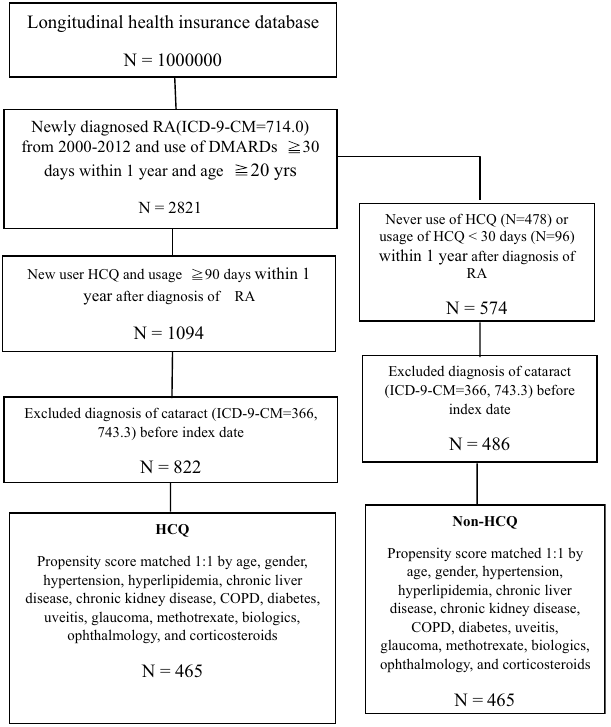
Figure 1. The flow chart of screening process. HCQ hydroxychloroquine, DMARDs disease modifying antirheumatic drugs, COPD chronic obstructive pulmonary